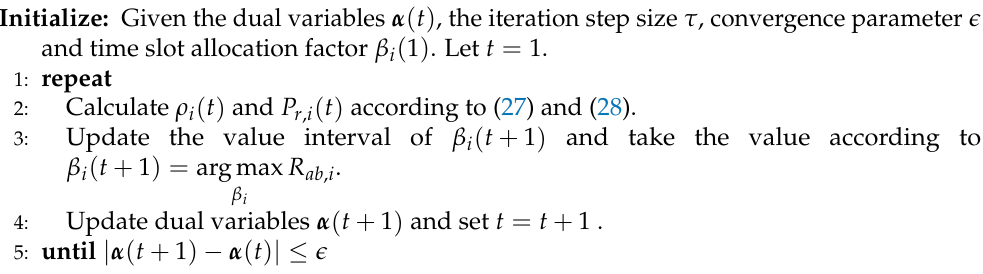
Algorithm 1 Proposed algorithm for the joint optimization problem in the SR-TWRS